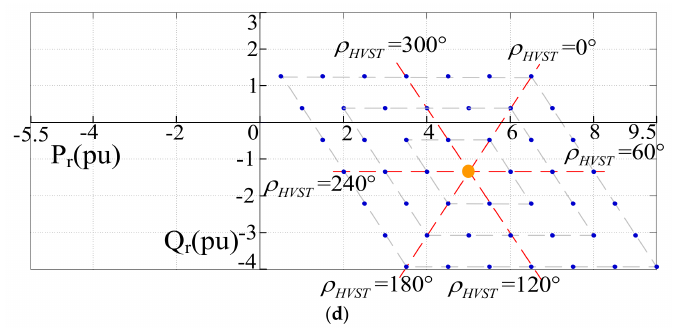
Figure 6. Relationship between P r and Q r with HVST regulation for different system phase angle offsets. ( a ) The phase difference is 0 ◦ ( δ = 0 ◦ ); ( b ) The phase difference is 10 ◦ ( δ = 10 ◦ ); ( c ) The phase difference is 20 ◦ ( δ = 20 ◦ ); ( d ) The phase difference is 30 ◦ ( δ = 30 ◦ ).